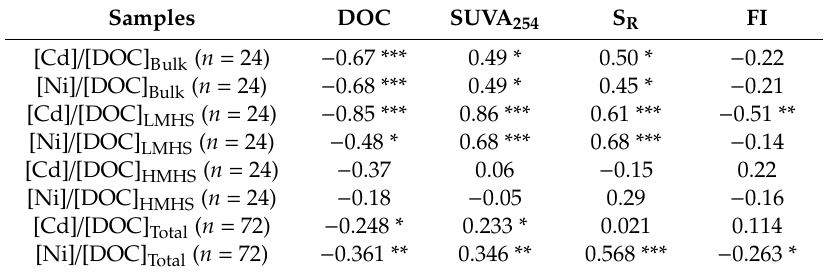
Table 4. Correlation coe ffi cients of [Me] / [DOC] ratios with the selected optical indicators and C contents. Samples